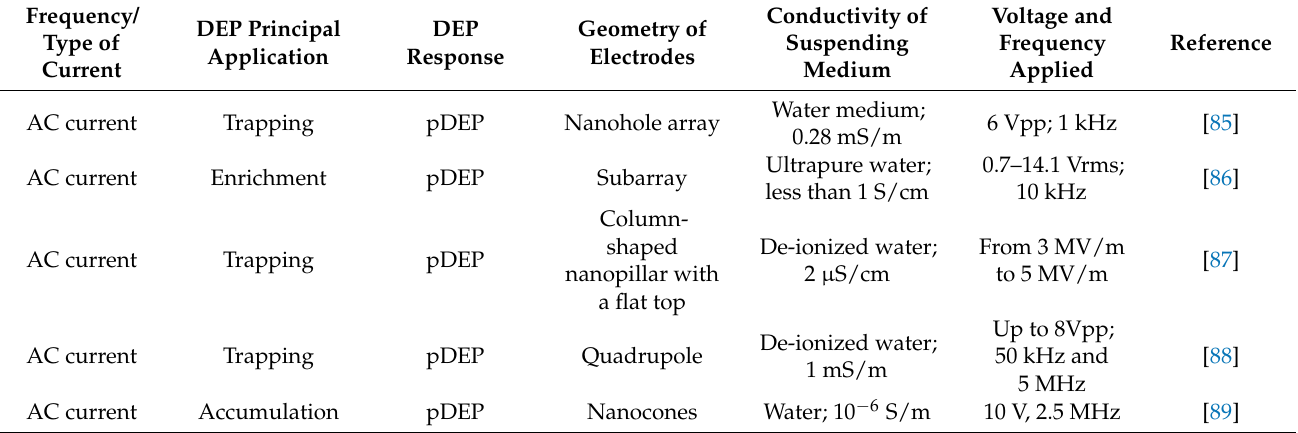
Table 5. Electrode-based-DEP type of electrode configuration studied for protein